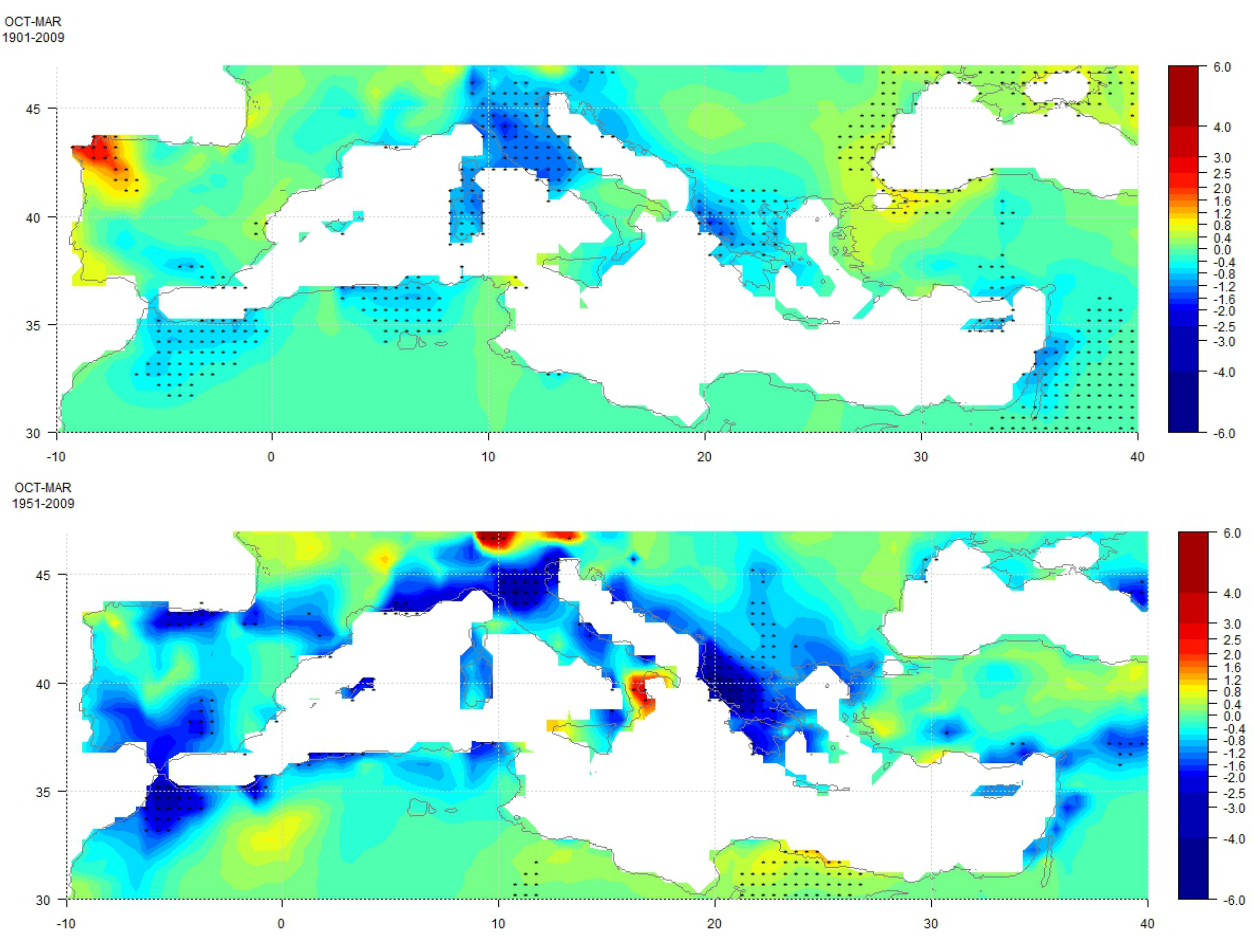
Fig. 4. Spatial distribution of precipitation trends for the rain season (October–March) concerning gridded datasets (CRU TS 3.1), for 1901–2009 (upper graph) and 1951–2009 (lower Spatial distribution of precipitation trends for the rain season (October-March) 1 concerning gridded datasets (CRU Τ S 3.1), for 1901-2009 (upper graph) and 1951-2009 2 (lower graph). 3